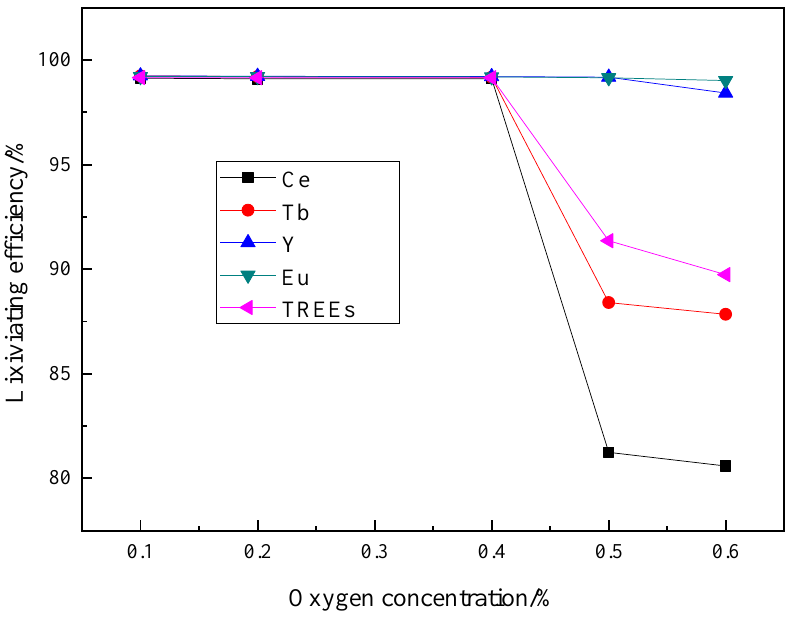
Figure 3. Influence of the oxygen concentration on the REEs leaching efficiencies (roasting temperature of 700 °C, roasting time of 3 h, mass ratio of phosphor powder to sodium hydroxide 1:3, HCl solution concentration of 8 mol·L −1 , acid leaching temperature of 60 °C, acid leaching time of 1 h, and liquid–solid ratio of 10:1.).